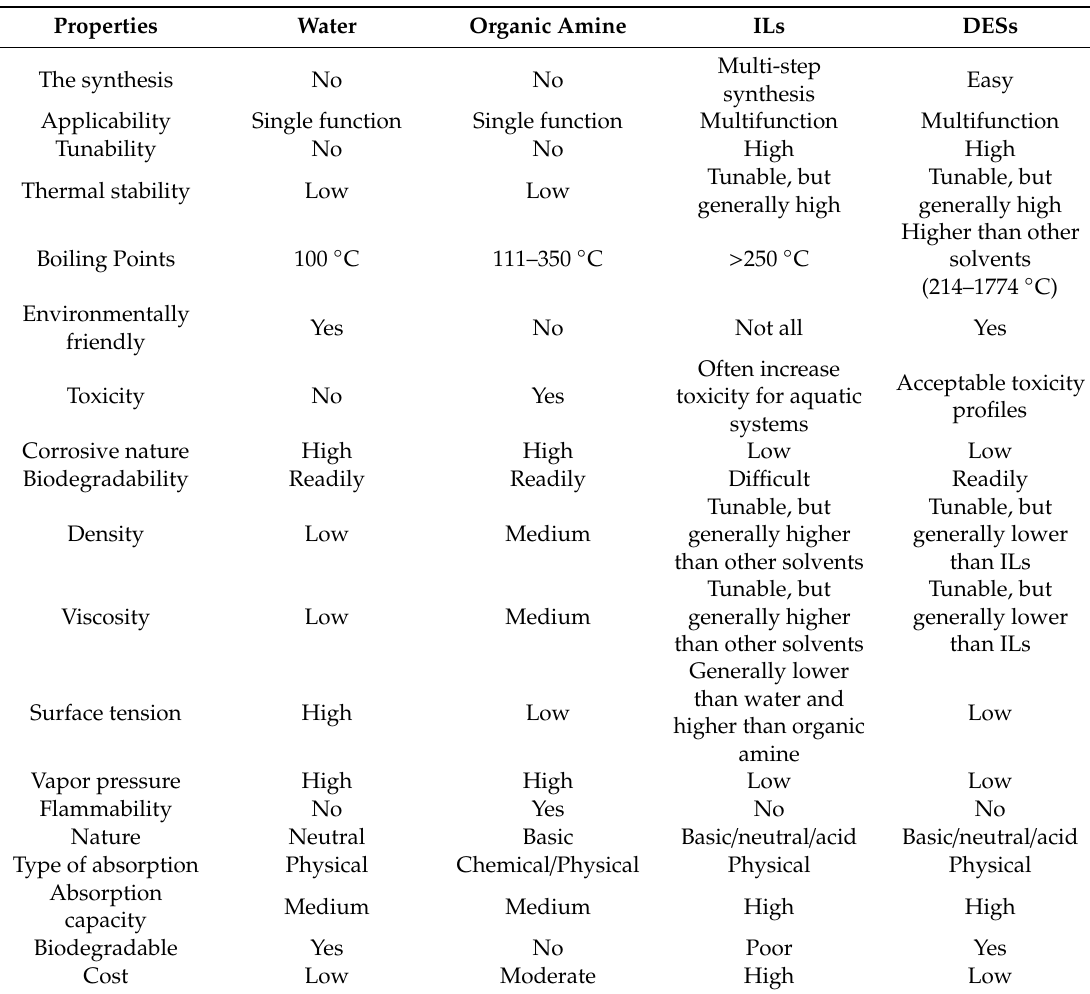
Table 1. Comparison of physicochemical properties of absorbents